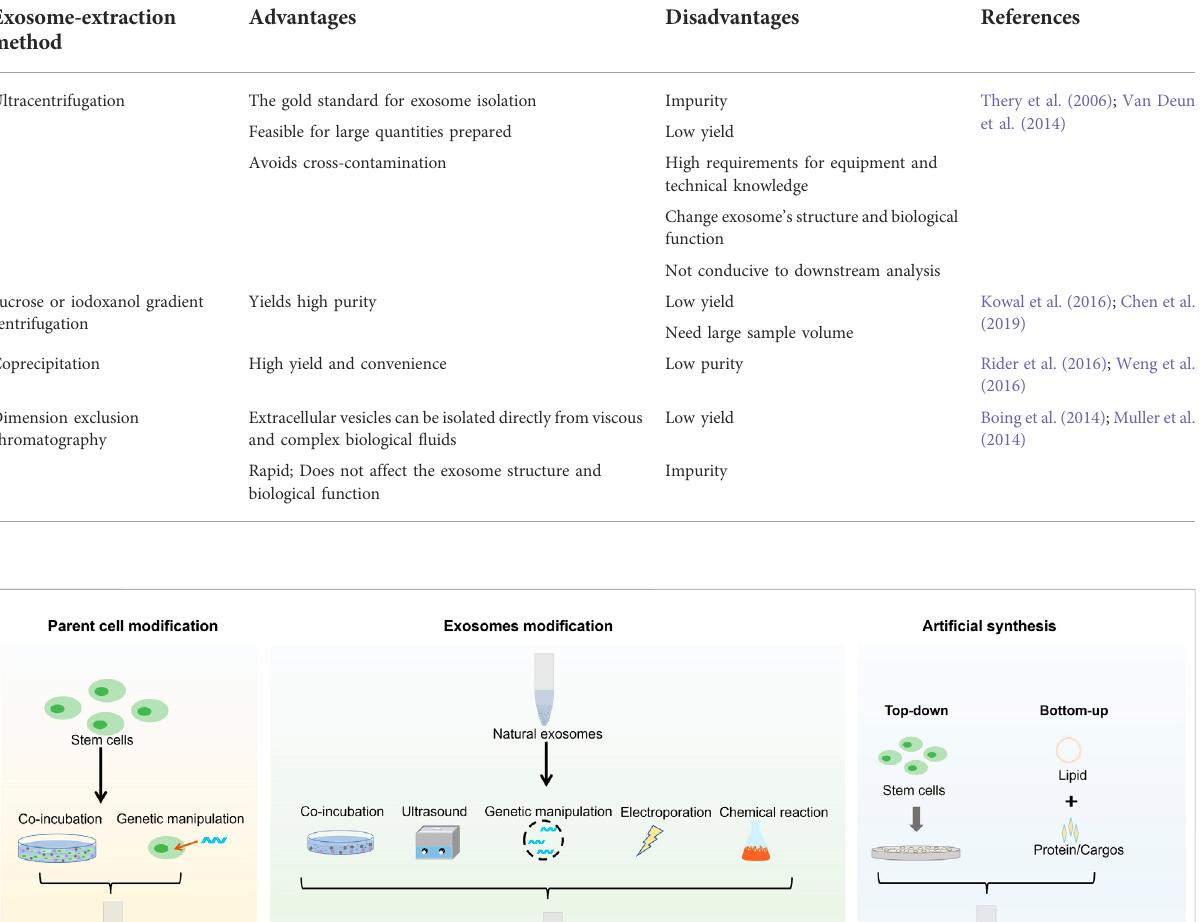
TABLE 1 Comparison of different exosome-extraction methods.